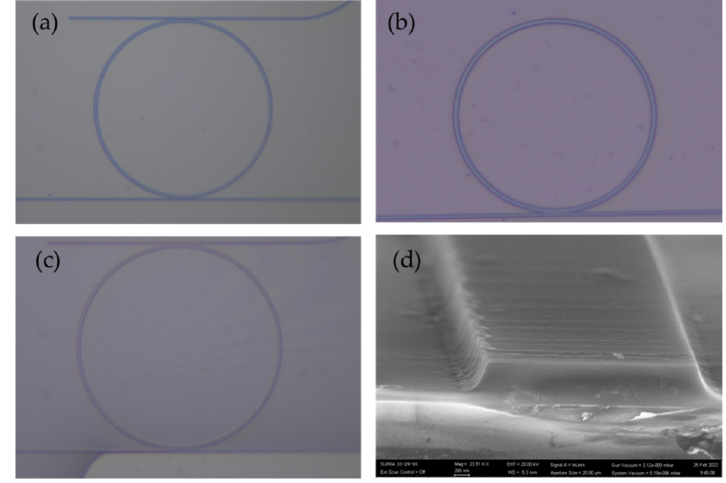
Figure 5. Images of the fabricated microresonators ( a ) without cladding layer, ( b ) with oxide cladding layer, and ( c ) with SU-8 polymer-cladding layer. ( d ) The SEM image of the air-cladded waveguide.